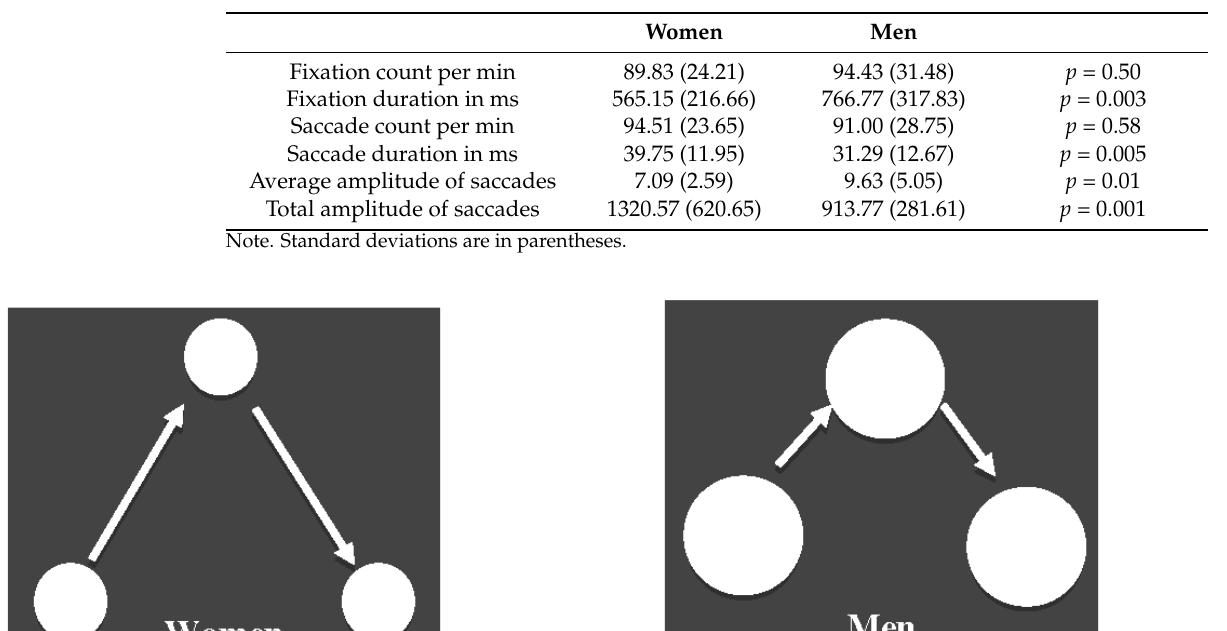
Figure 1, women demonstrated shorter fixations [ t (68) = 3.10, p = 0.003, Cohen’s d = 0.74] but larger duration of saccades [ t (68) = 2.87, p = 0.005, Cohen’s d = 0.69] and larger average [ t (68) = 2.65, p = 0.01, Cohen’s d = 0.61] and total [ t (68) = 3.53, p = 0.001, Cohen’s d = 0.84] Table 1. Characteristics of eye movements under both conditions. Table 1. Characteristics of eye movements under both conditions.